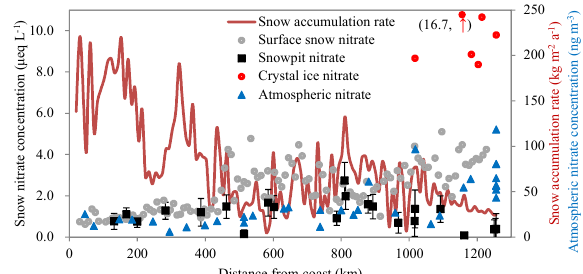
Figure 1. Concentrations of NO 3- in snow (surface snow, crystal ice and snowpits; on the primary y -axis) and atmosphere (on the secondary y -axis), with error bars representing one standard deviation of NO 3- (1σ) for individual snowpits. Also shown is the annual snow accumulation rate on the traverse (red solid line; based on Ding et al. (2011)). Note that NO 3- concentration in one crystal ice sample (red dot) is higher than the maximum value of the primary y -axis (NO 3- concentration = 16.7 µeq L -1 in the